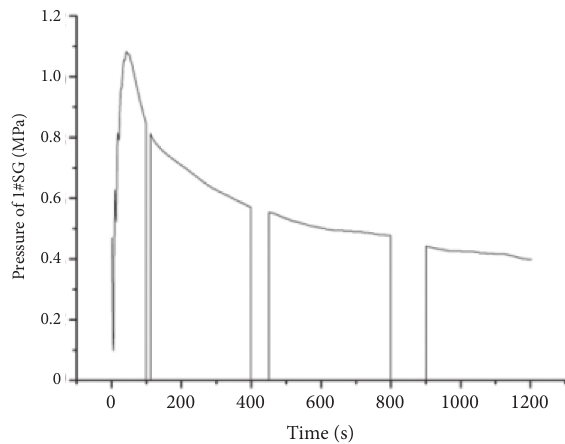
Figure 9: Curve after setting missing.